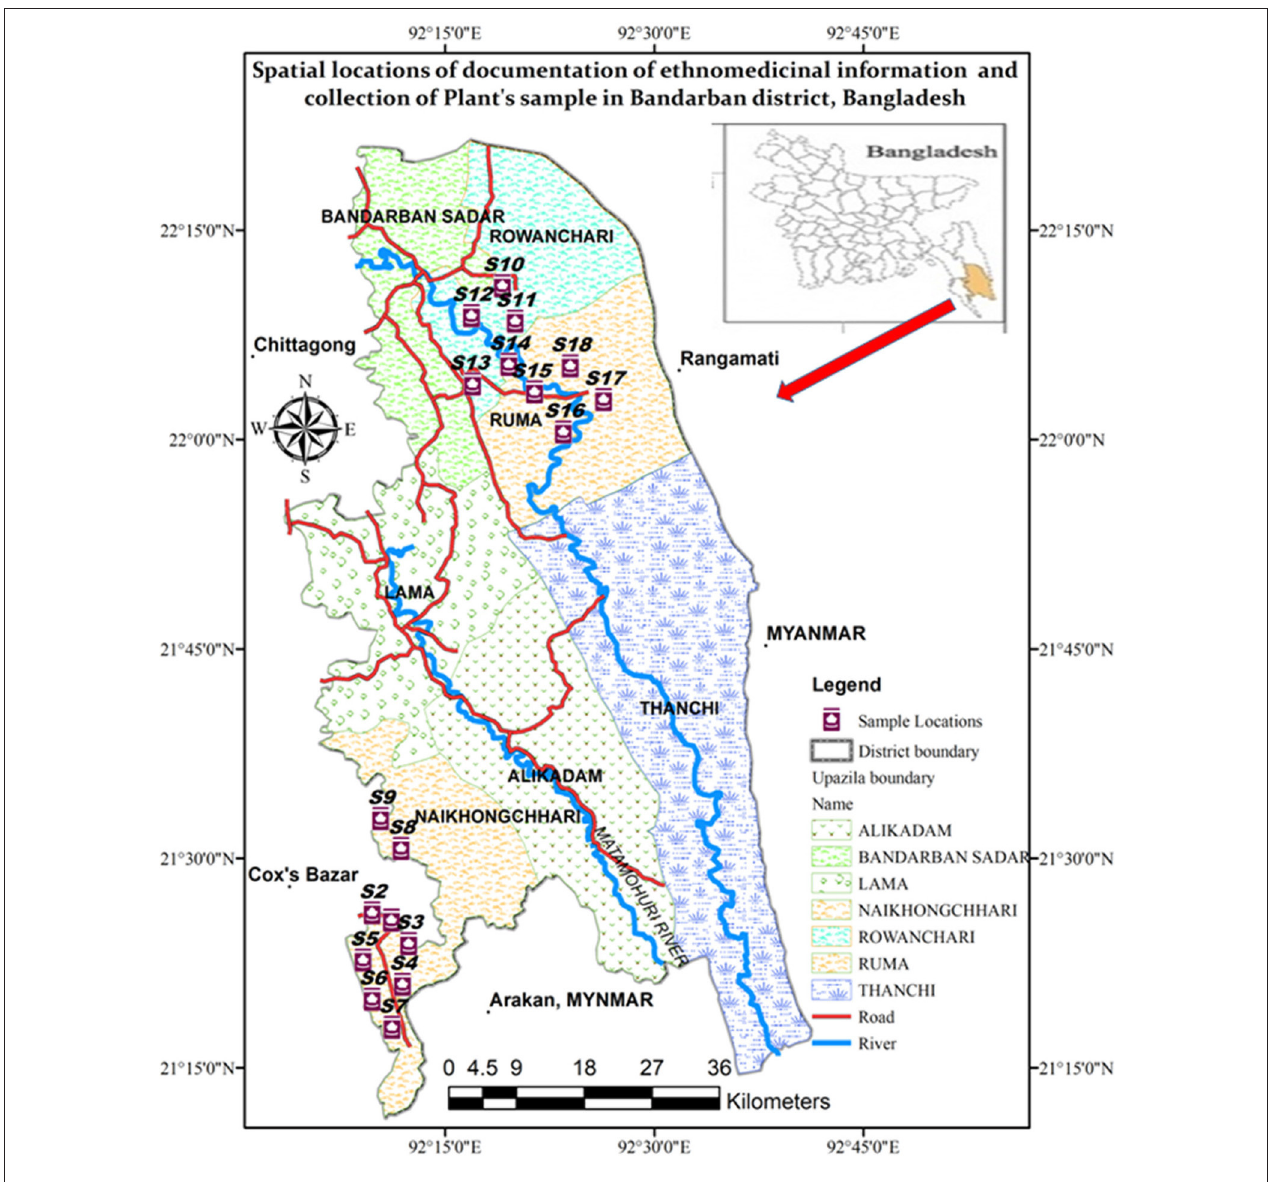
FIGURE 1 | A map of the study